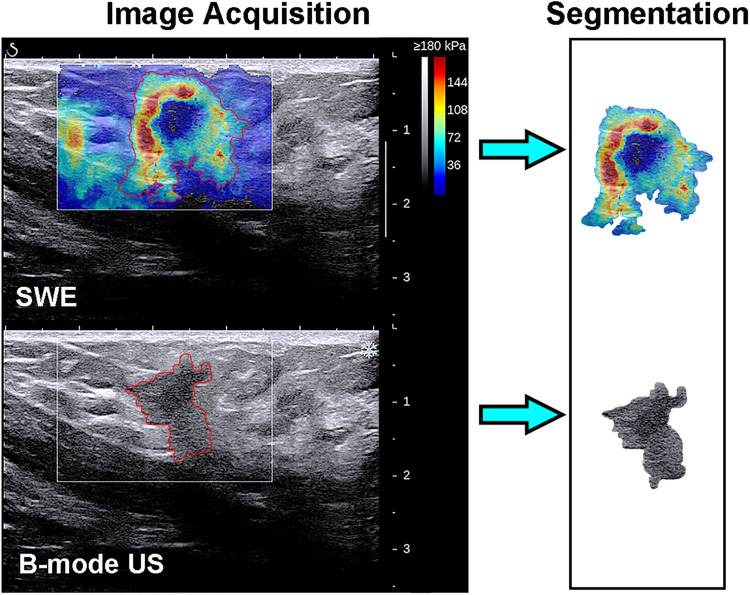
Images show a grade 3 invasive ductal carcinoma in a 58-year-old woman. Top left: The shear-wave elastography (SWE) image shows a non-homogeneous mass, the region of interest encompassing the whole mass and adjacent breast tissue, and the contour line located in the border of light blue and green. Bottom left: B-mode ultrasonography (US) image shows an irregular hypoechoic mass considered to be a Breast Imaging Reporting and Data System category 4c lesion, and the region of interest encompassed the hypoechoic region which represented the tumor. The segmented SWE image (top right in black box) and B-mode US image (bottom right in black box) were used for further deep learning-based radiomic feature extraction.